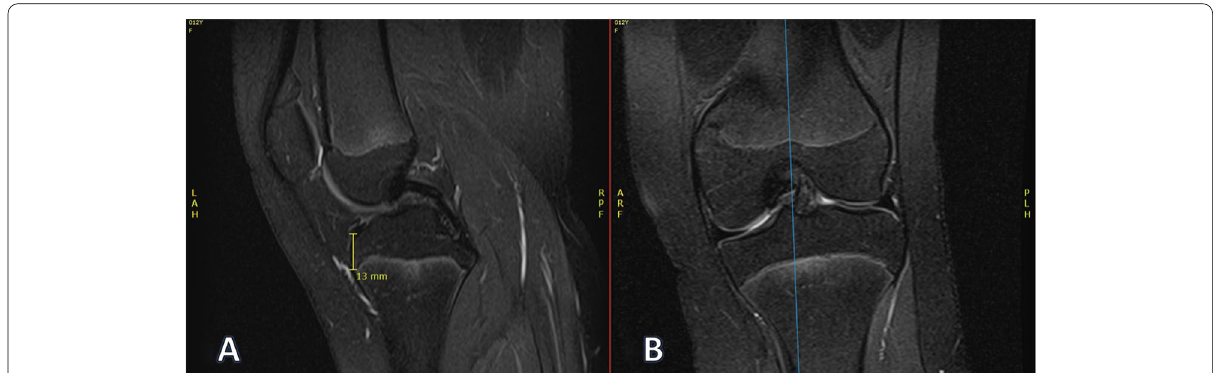
Fig. 6 Example tibial epiphysis height measurement. A Height of tibial physis (13 mm). B Corresponding coronal location of measurement. This measurement was made just lateral to the medial tibial spine to approximate ACL tibial tunnel position